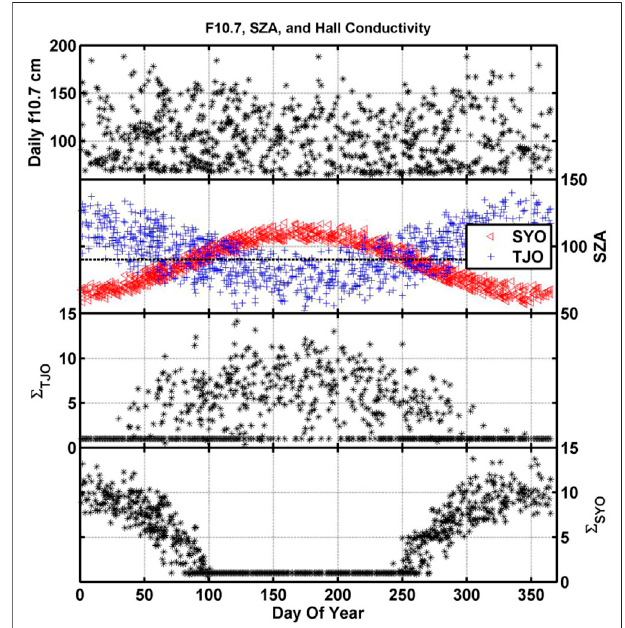
FIGURE 15 | Variation of height-integrated ionospheric conductivity due to solar illumination as a function of the day of year for all our onset events. In the top panel is the solar radio fl ux at 10.7 cm, and in the second panel is the solarzenithangleforTJO(blue)andSYO(red).Thedashedlinemarkeda SZA = 90 ° . The third panel show the TJO height-integrated ionospheric conductivity, and the forth panel show the conductivity for